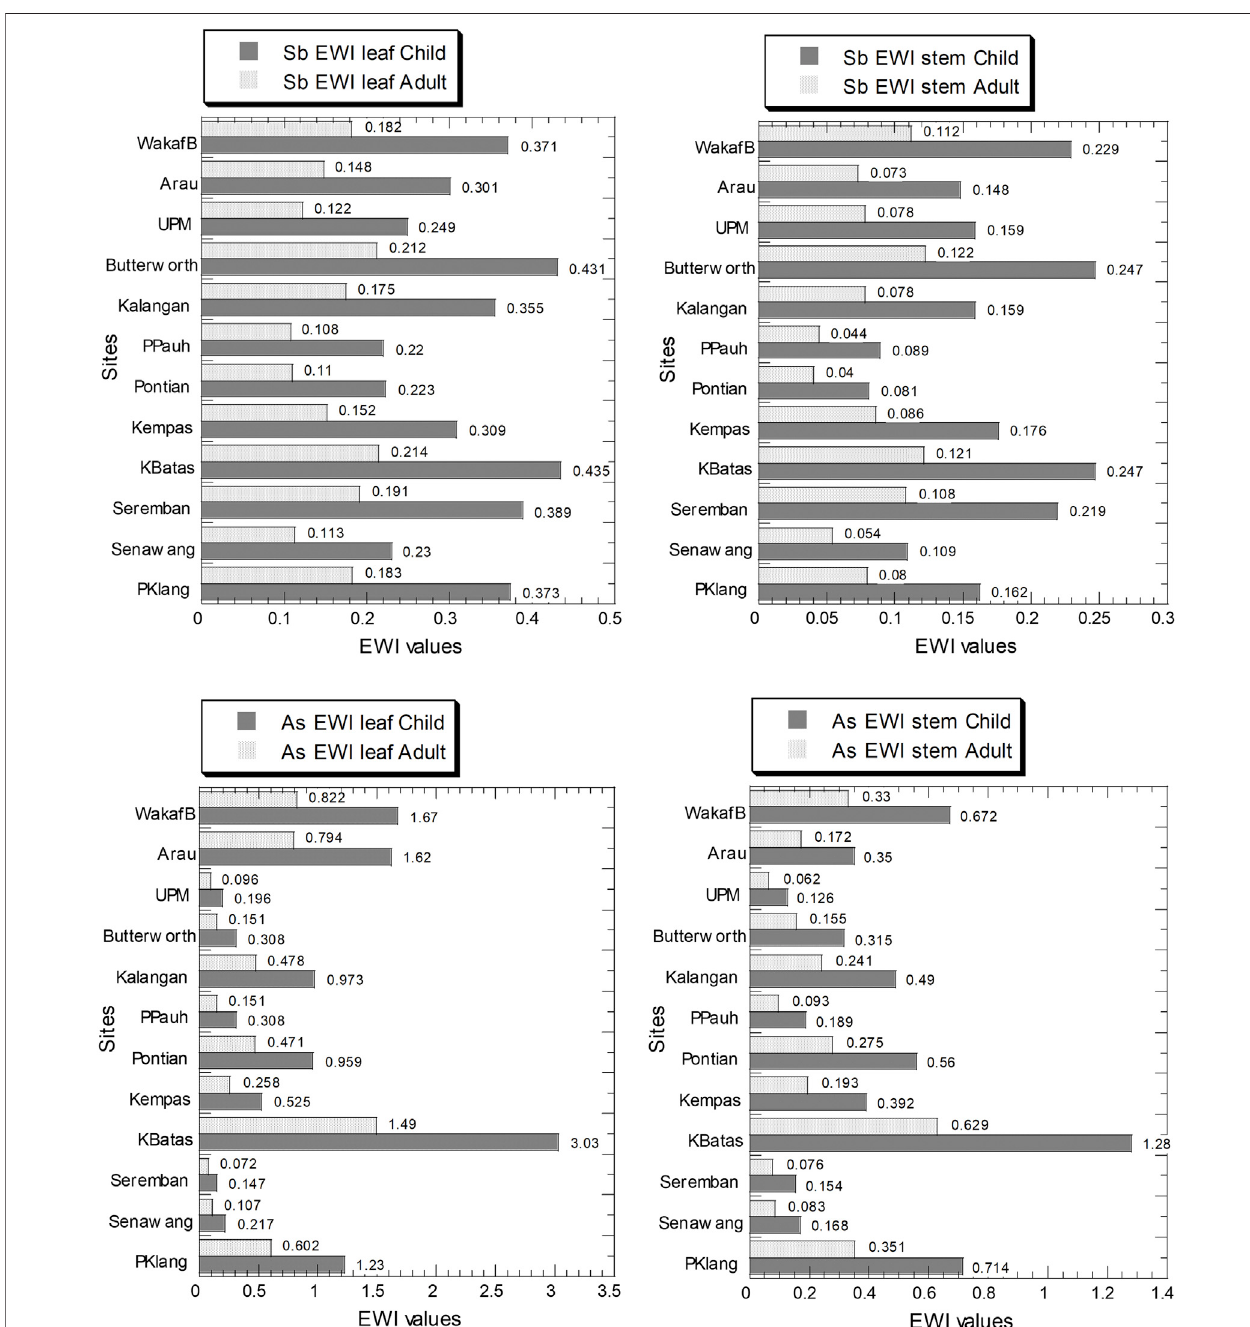
FIGURE 5 | Estimated weekly intake (EWI) values (µg/kg wet weight/week) of Sb and As in the leaves and stems of Centella asiatica collected from 12 sampling sites (numbers in white circles (1 – 12) in Figure 1 ; S1 – S12 in Supplementary Table S1 ) in Peninsular Malaysia. The X -axes are based on a linear scale.